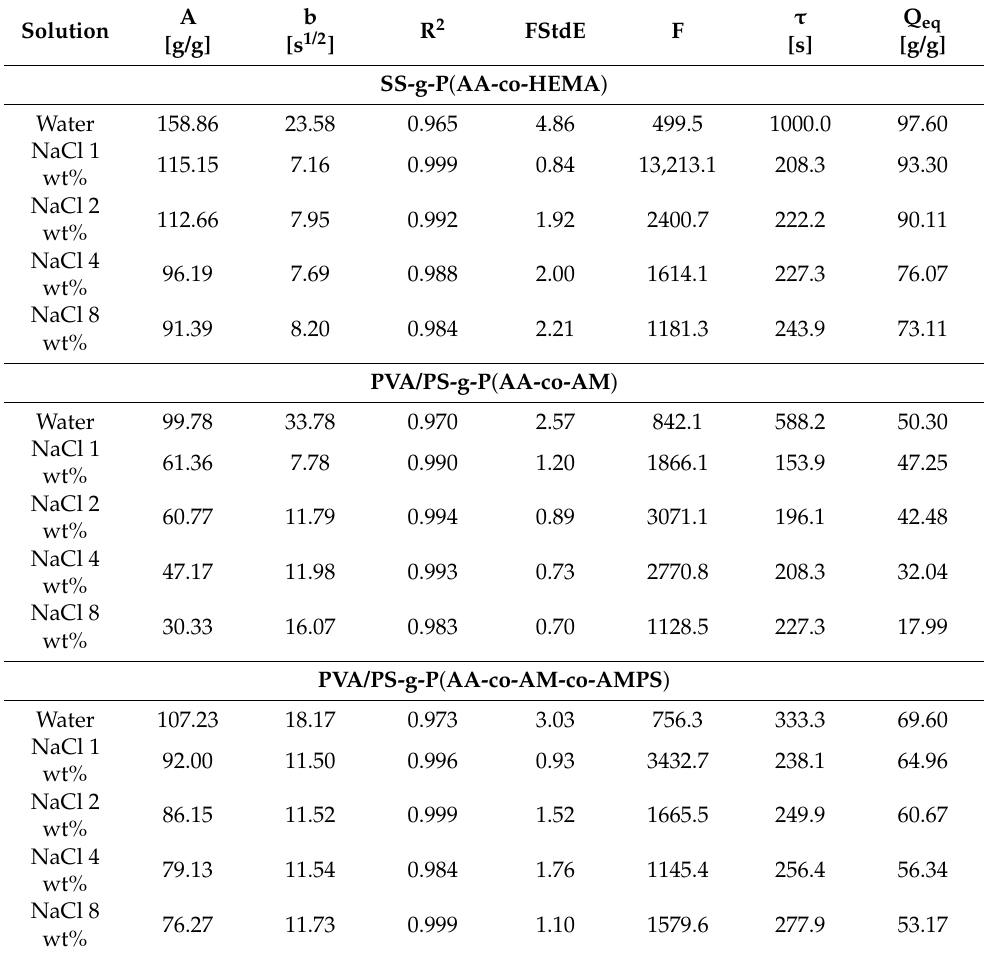
Table 3. The collection of the results of fitting the experimental data to Equation (4) and values of parameter τ calculated from Equation